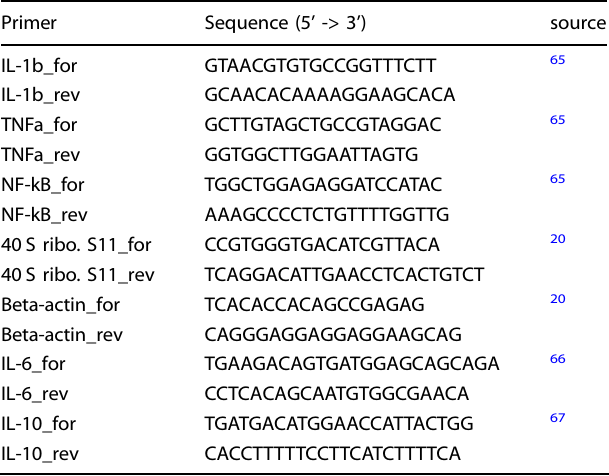
Table 1. Oligos used for real-time-RT-PCR of KHV infected CCB